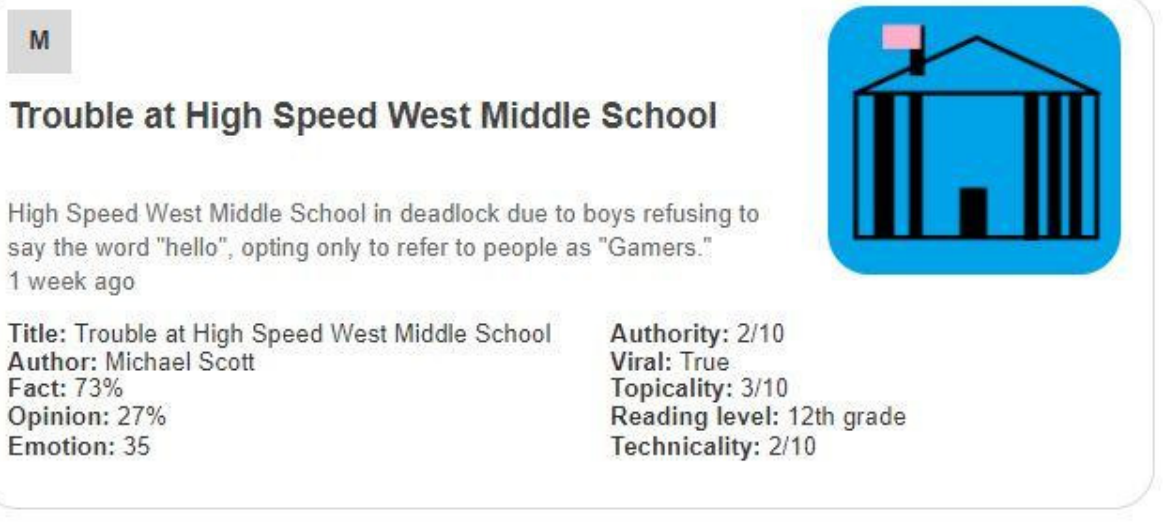
Figure 3. Informational label with article summary [76].